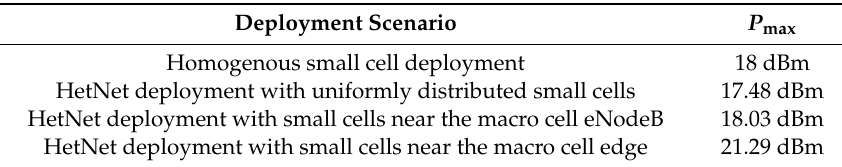
Table 2. P max limit for various network